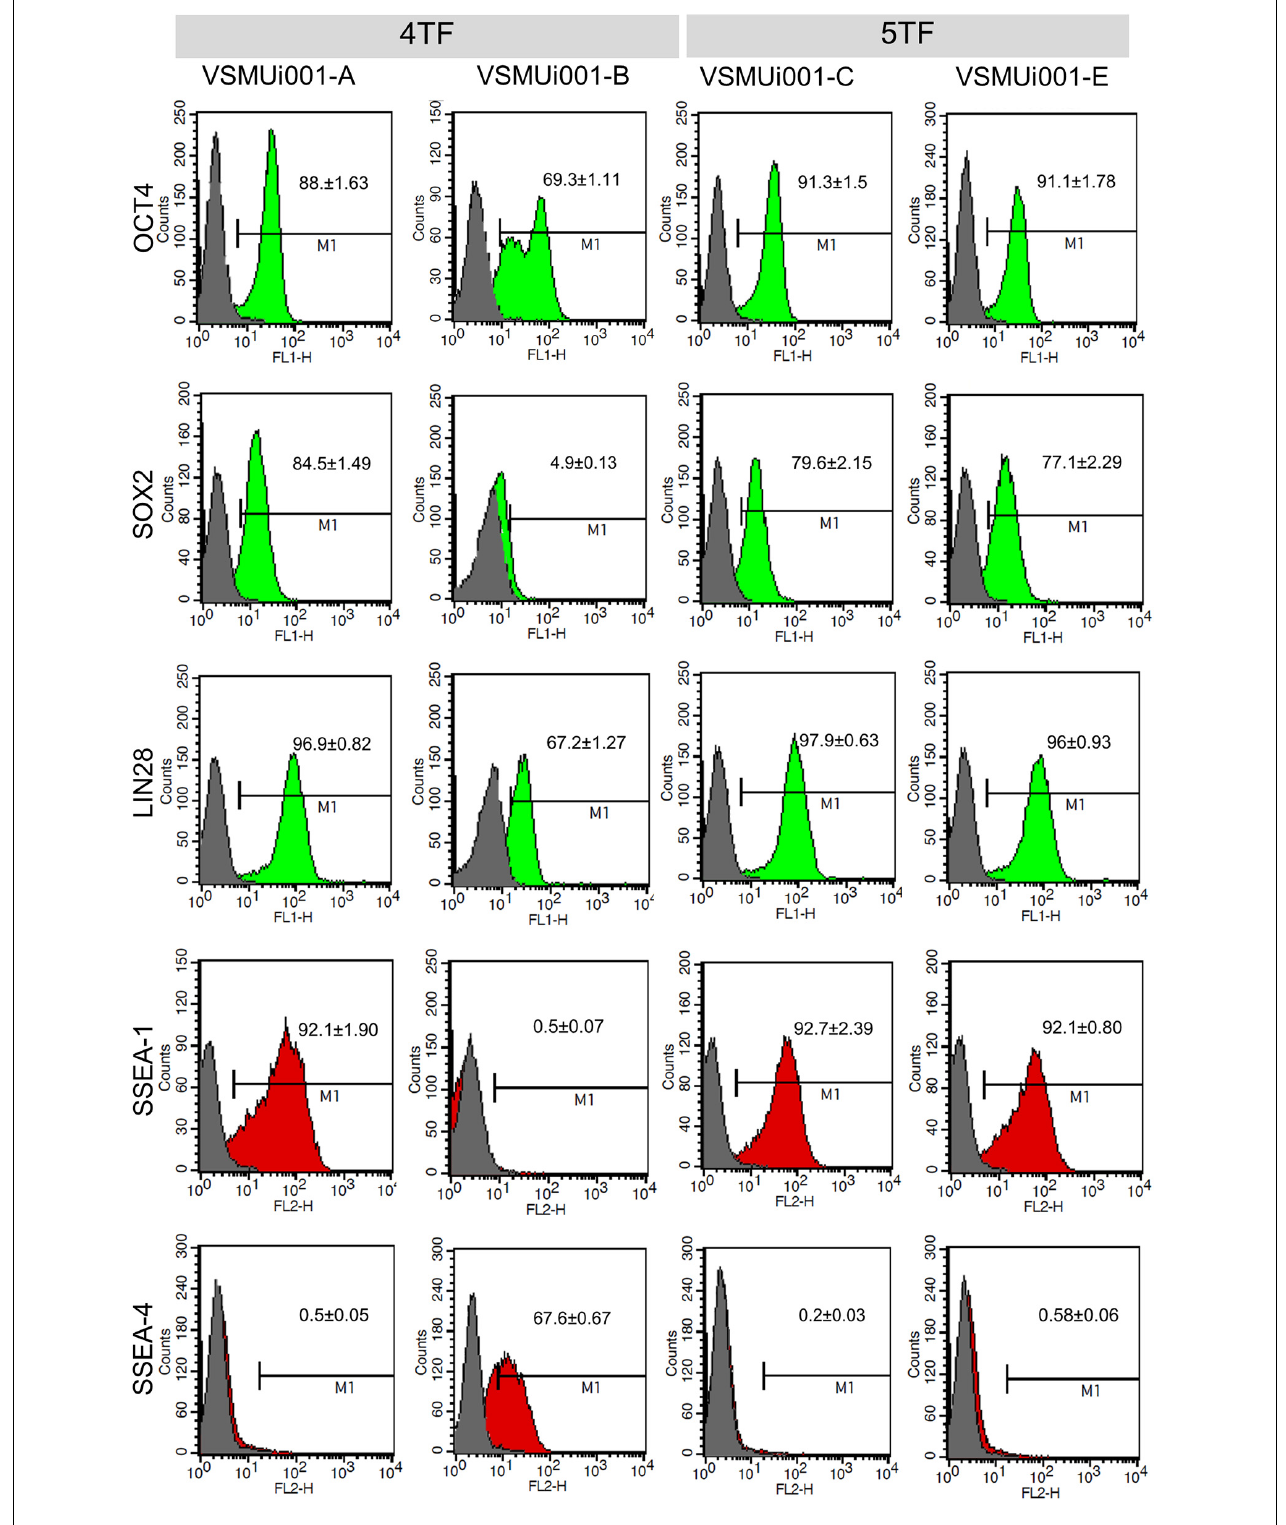
FIGURE 5 | Flow cytometric analysis of pluripotency markers expressed by various porcine-induced pluripotent stem cell lines. 4TF, induction using OCT4, SOX2, KLF4, and C-MYC; 5TF, induction using OCT4, SOX2, KLF4, C-MYC, and LIN28. OCT4, octamer-binding transcription factor 4; SOX2, SRY-box transcription factor 2; LIN28, Lin-28 homolog A; SSEA, stage-specific embryonic antigen.